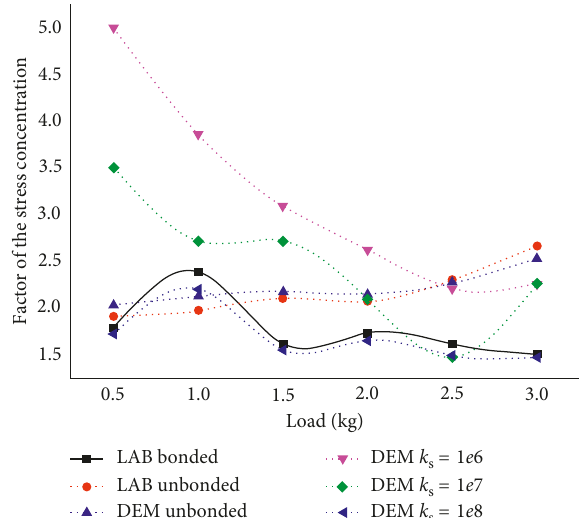
Figure 16: Comparison of stress concentration factor between the photoelastic mode test and DEM